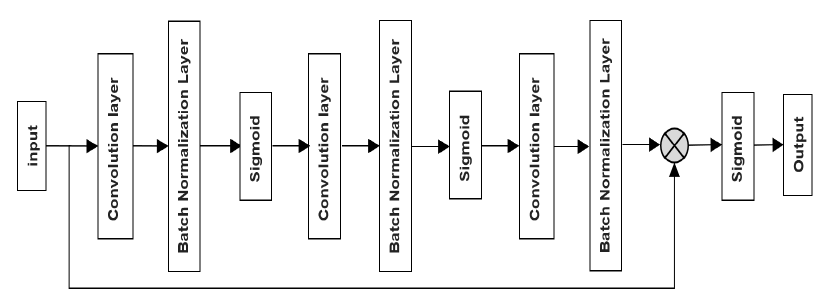
Figure 4. Residual